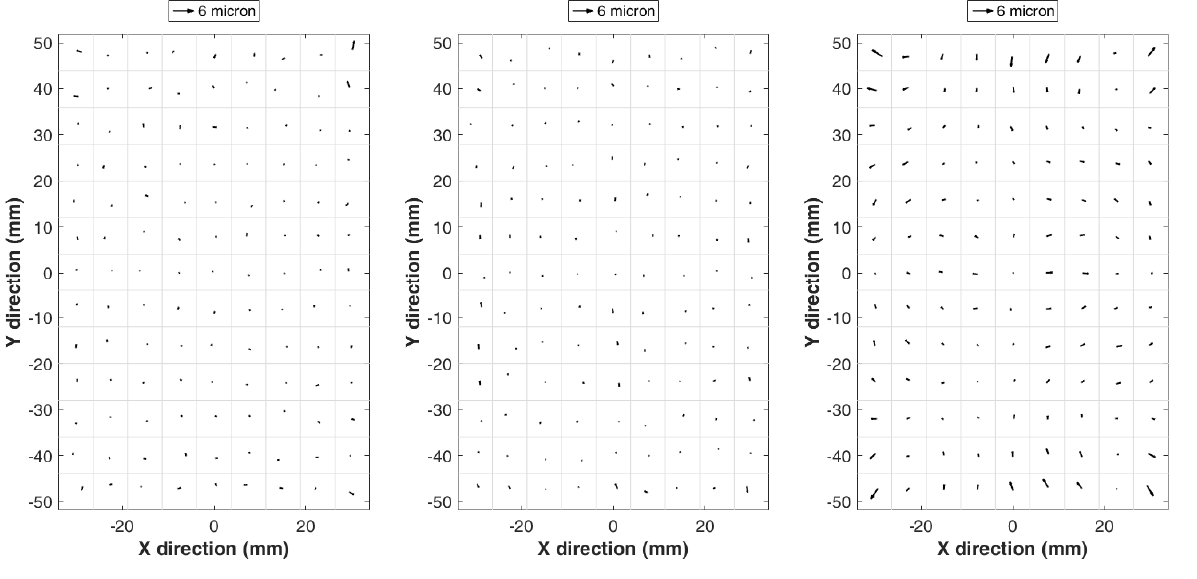
Figure 5. Average residual vectors of the photo coordinate observations in Case 1-1 (left), Case 2-1 (middle), and Case 3-1